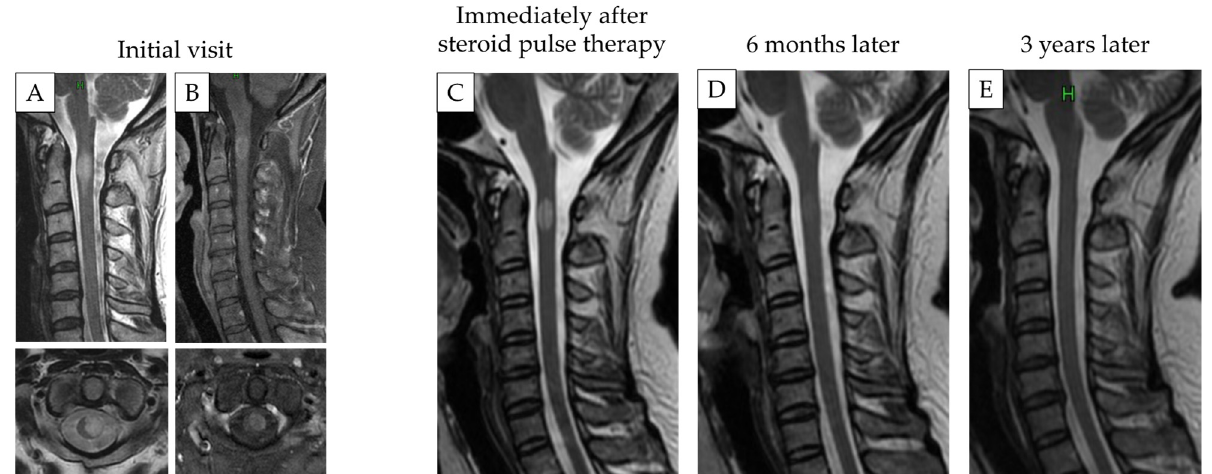
Figure 3. Representative MRI images of patients with atopic myelitis. Gadolinium-enhanced T2- ( A ) and T1-weighted MRI images ( B ) at the initial visit. Intramedullary signal change with cord enlargement was observed at the C1/2 level. ( C – E ) T2-weighted MRI immediately ( C ), 6 months ( D ), and 3 years ( E ) after steroid pulse therapy. The high-signal intensity disappeared over time.